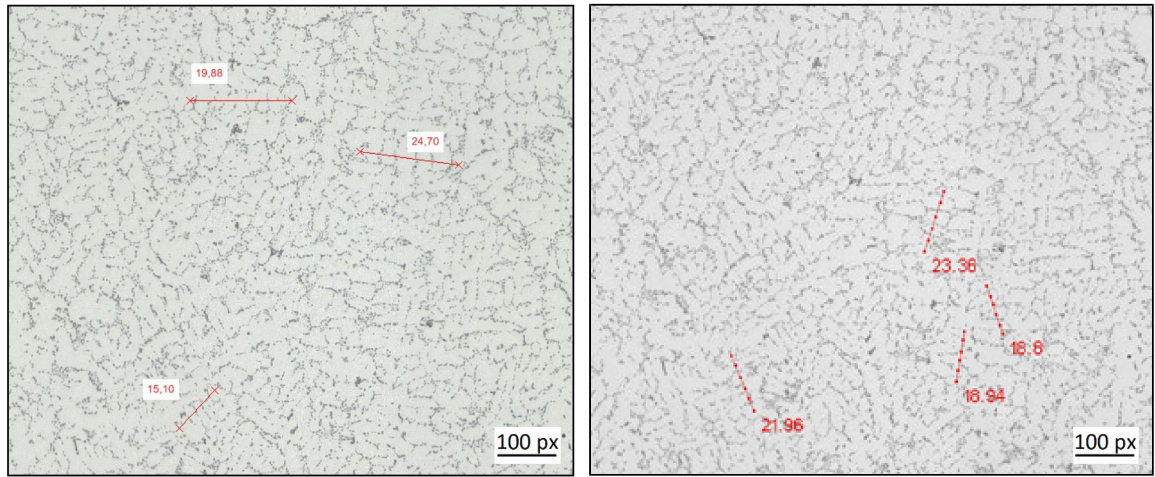
Figure 4. Comparison of manual (left) and automated (right) dendrite measurements exemplified for the 5th/6th sub-image of structure 1.